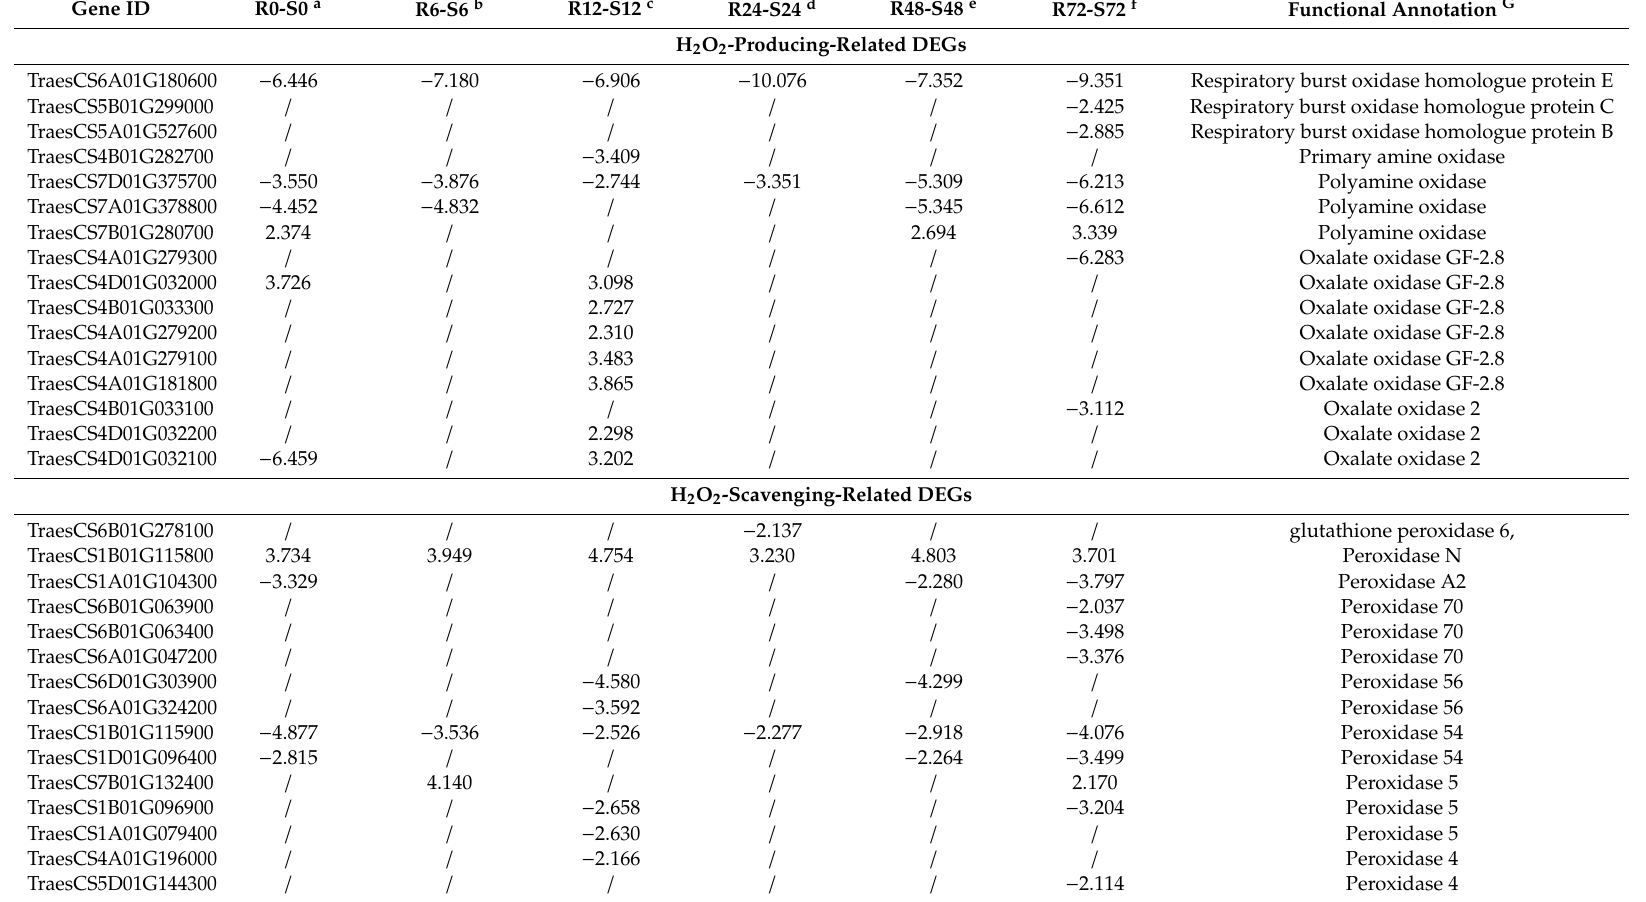
Table 1. List of DEGs involved in H 2 O 2 production and scavenging between L658 and L958 at each time